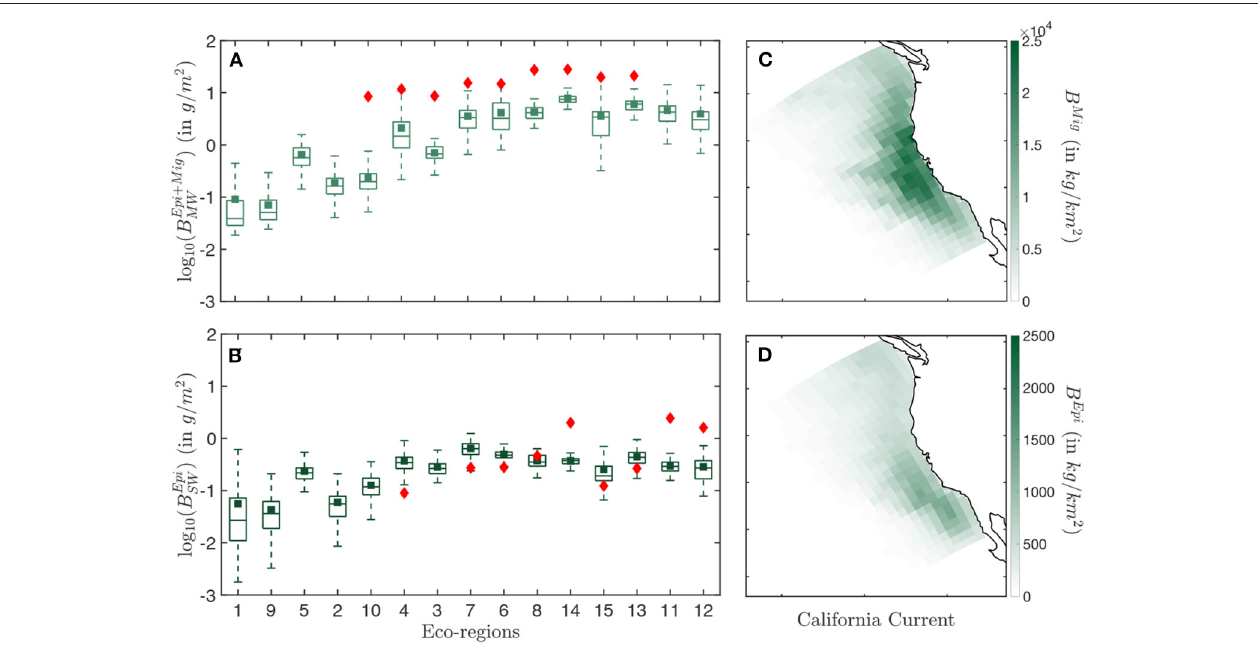
FIGURE 5 | Biomass distribution in the California Current. (A) Simulated (light green) and observed (red) biomass densities B Epi + Mig per eco-regions for the mid water (MW) trawls. (B) Simulated (dark green) and observed (red) biomass densities B Epi per eco-regions for the surface water (SW) trawls. (C) Spatial distribution of the annual mean biomass density for the migratory community B Mig binned in 1 x = 96km grid cells. (D) Spatial distribution of the annual mean biomass density for the epipelagic community B Mig , binned in 1 x = 96 km grid cells. The simulation results in (A,B) are determined from the average of years 1999–2006. Eco-regions are ranked from low to high primary production. In the box-plot the central mark indicates the median, the bottom, and top edges of the box indicate the 25th and 75th percentiles, respectively, while the whiskers extend to the most extreme data points that are not considered to be outliers. The square marker is the averaged biomass density per eco-region, and the diamond the averaged observed biomass density per eco-region.